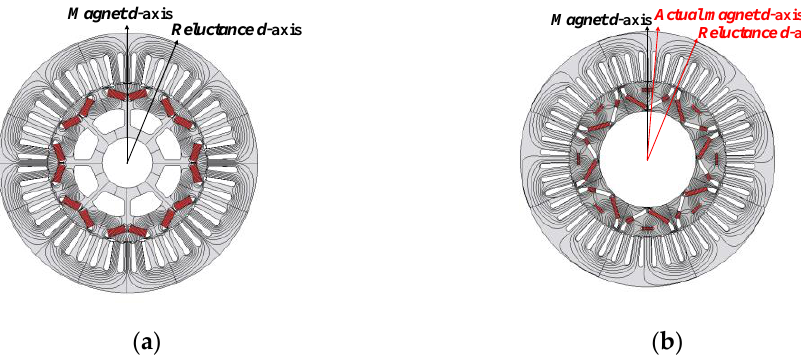
Figure 2. No-load magnetic fields. ( a ) The Prius 2010 machine. ( b ) The MAS-IPM machine.